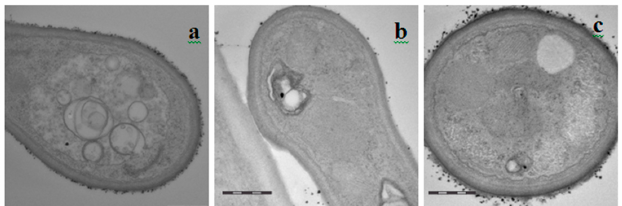
Figure 1. Longitudinal (panels a and b) and transverse (panel c) sections of fungal hyphae of M. fijiensis in the intracellular space of the mesophyll tissue of banana leaf of: control untreated ( a ); mineral oil-treated ( b ); and difenoconazole-treated ( c) leaves (magnification ×50,000).